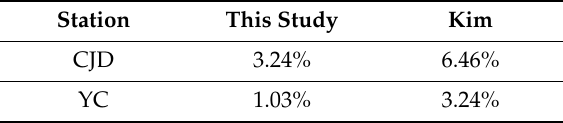
Figure 6. Index flood relation. Table 2. Comparison of relative errors for index flood.